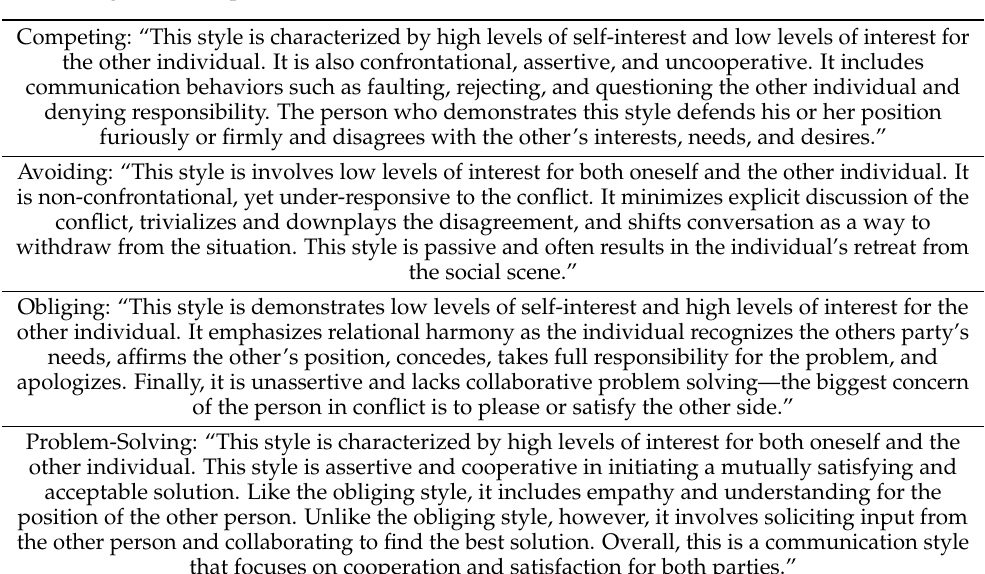
Table 2. Definitions of the identified conflict management styles in intergenerational conflict (adapted from Zhang et al. [22] (p. 73) unless otherwise